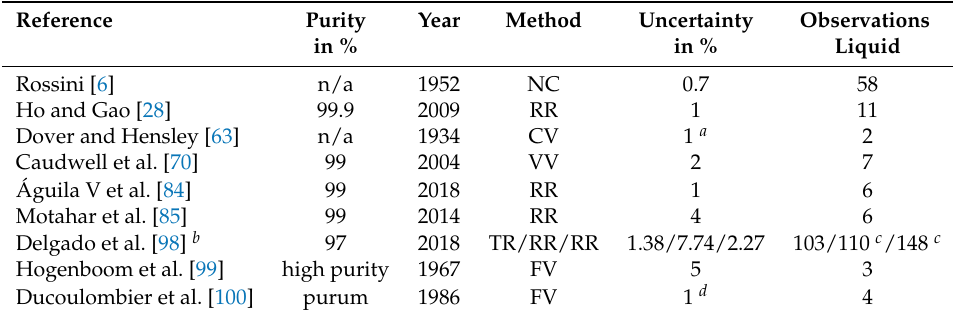
Table 5. Summary of viscosity data from the literature.